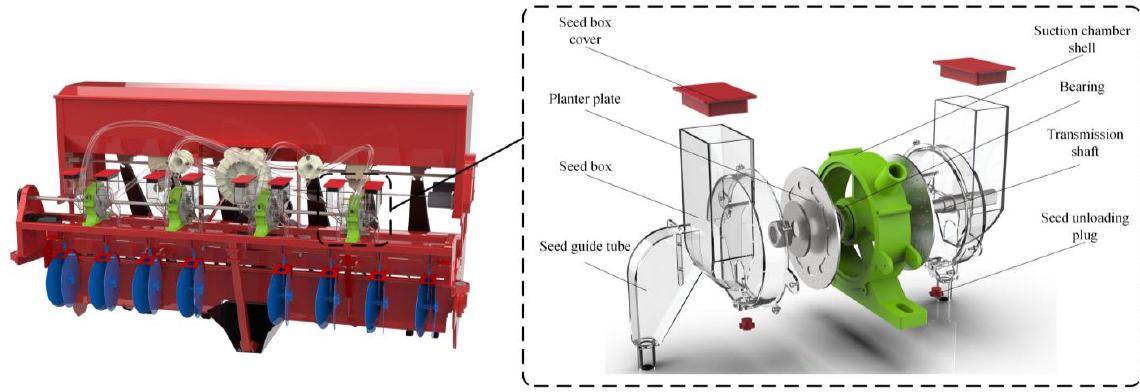
Figure 1. View of the seed metering device in fragments.